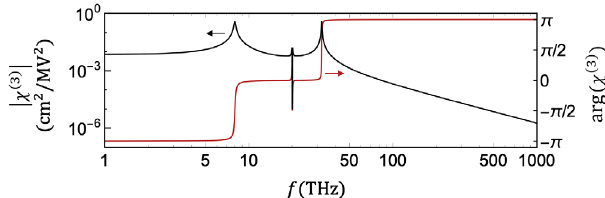
FIG. 3. Magnitude (black) of the third-order IRRS susceptibil- 3 Þ Q ity χ ð resulting from bQ for an IR phonon at 20 THz with R IR b;b ˜ Z (cid:2) effective charge ¼ 1 e coupled to a Raman phonon at 12 THz with a coupling strength b ¼ 1 e= Å. The sum and difference frequencies are 32 and 8 THz, respectively. The phase (red) is referenced to the right vertical